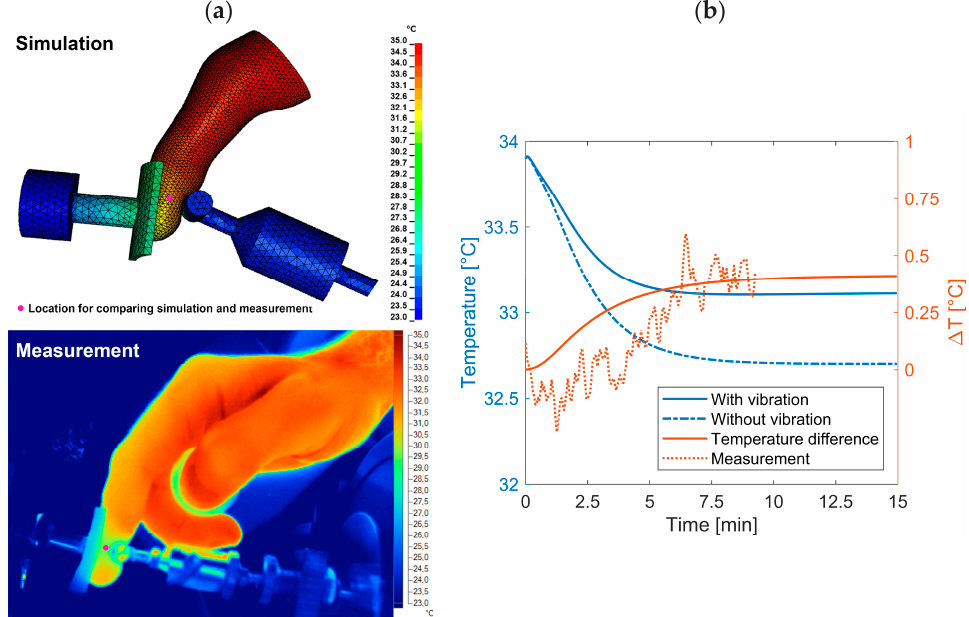
Figure 11. Comparison between simulation/measure of the increase in temperature induced by the vibrations. The calculation performed with the basal rate of blood perfusion; ( a ) temperature field; ( b ) temperature simulated with and without vibration and vibration-induced increase in temperature simulated and measured for a given position (pink ellipse).